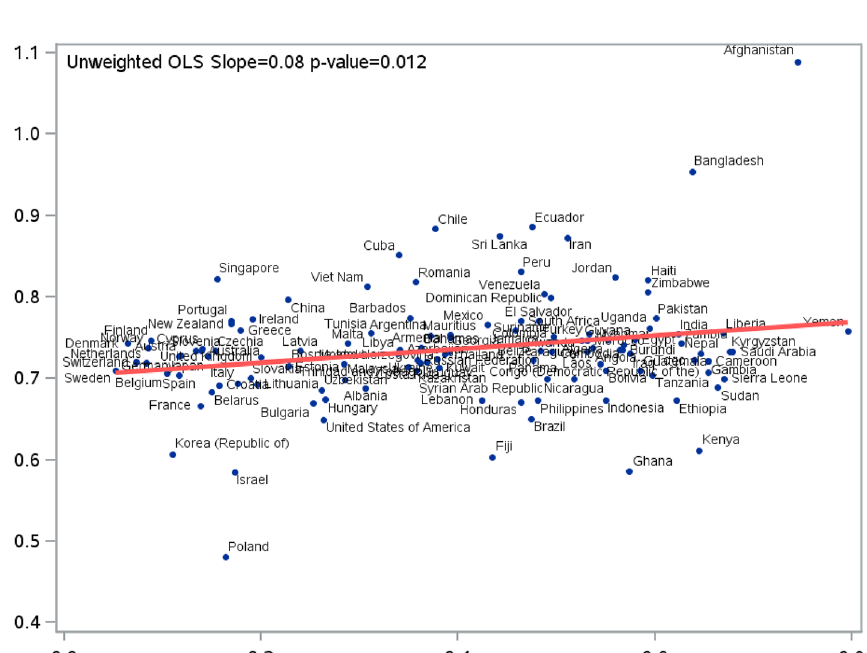
Figure 1. Results of hierarchical model-specific predicted country-specific hazard ratios (HR) of ischemic stroke in women compared men (Y-axis) and their association with country-level gender inequality index (GII) (X-axis) presented using unweighted linear regression. Predicted country-specific HRs are obtained from a model that adjusts only for sex and allows random slopes for